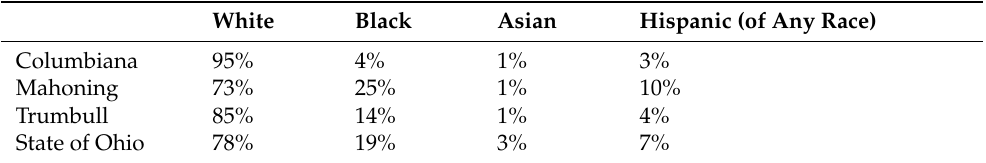
Table 1. Child race and ethnicity (2020 estimates)